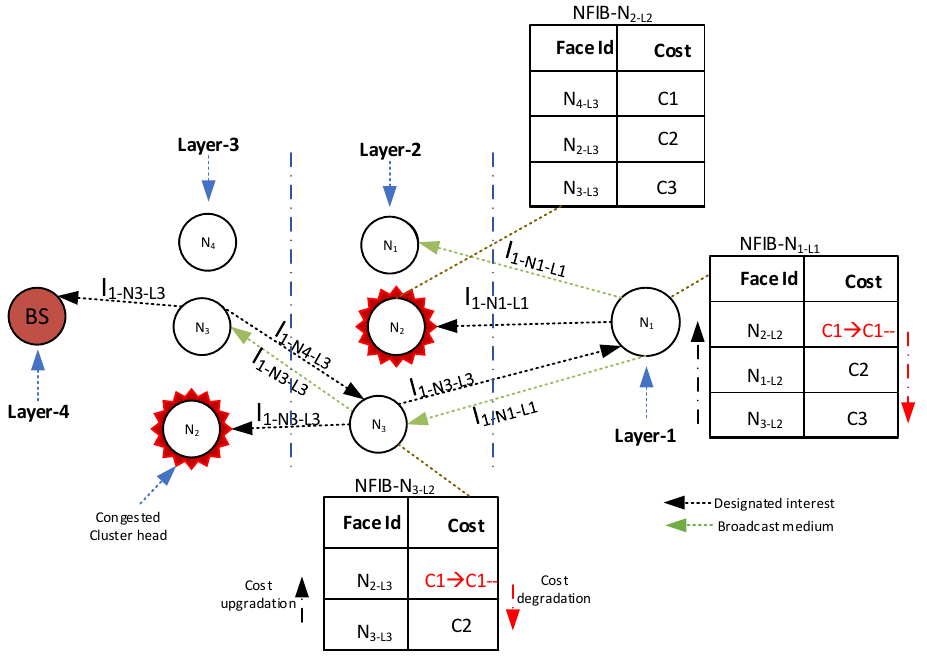
Figure 5. Upstream Interest packet